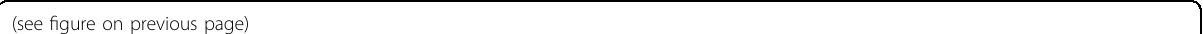
Fig. 1 Decreased autophagy and polyamine synthesis in aged and OA human and murine cartilage. a – c Autophagy gene expression in isolated chondrocytes from young (21 – 37 years), old (62 – 68 ) and OA (49 – 86 years) knee joints ( n = 3). d Representative images (x20) of LC3 protein expression in knee joints of WT mice at 2 months (young) or 16 months (old) of age. e Quanti fi cation of LC3 positive cells/total from murine knee joints ( n = 4). f Representative EM images of chondrocytes from microdissected cartilage obtained from knee joints of WT young (2 months) or old (16 months) mice. White arrows highlight autophagosomes. Red boxes highlight the area of magni fi cation. Scale bars: 1 μ m. g Quanti fi cation of autophagosomes in chondrocytes (microdissected cartilage) from murine knee joints ( n = 18 cells per mouse. six mice used). h – k RT-qPCR analysis gene expression of key enzymes involved in polyamine synthesis from isolated chondrocytes from young healthy (21 – 37 years) or old (62 – 68 years) ( n = 3). l – o RT-qPCR analysis gene expression of key enzymes involved in spermidine synthesis in microdissected cartilage obtained from knee joints of WT young (2 months) or old mice (16 months) ( n = 3). p – s RT-qPCR analysis of gene expression of key enzymes involved in spermidine synthesis in non-OA and OA human chondrocytes ( n = 3). All RT-qPCR gene expressions were normalised to the endogenous level of 18s. All data are expressed as mean ± S.E.M of n observations. Students unpaired t -test was used for statistical analysis. p < 0.05, p < 0.01 or p < 0.001 represented in all tables and Figures as *, **, or ***, respectively. NS non – signi fi